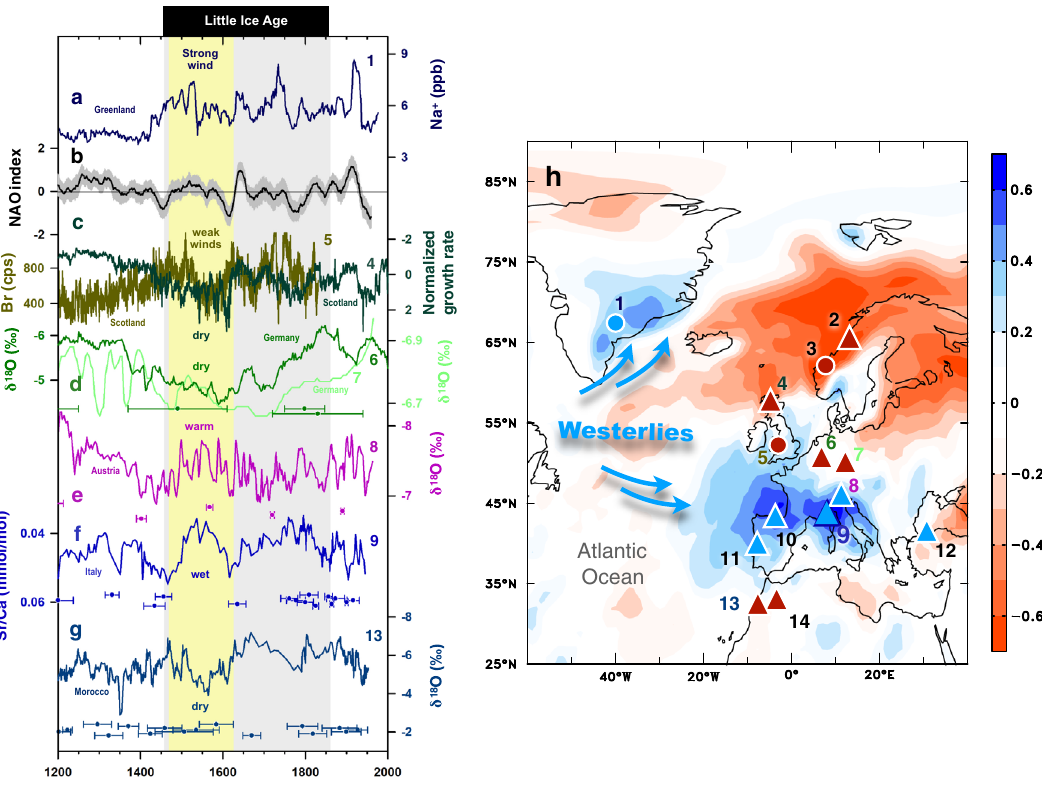
Fig.2|ClimaterecordsfromEuropeandnorthernAfricaforthelast800years. a Na + concentration in ice core GISP2 as an indicator of wind strength 34 . b Reconstructed North Atlantic Oscillation (NAO) index 11 . c Green: Stalagmite growth rate from Roaring cave (Scotland) as a proxy of precipitation amount. Low growth rate indicates positive NAO phase 35 . Mustard: Bromine concentration from aeoliansediments asaproxyof wind strength. High values indicate strong winds 36 . d Bunker (dark green) and Bleßberg (light green) δ 18 O record from Germany 37 – 39 . Lowvalues re fl ect a warm and wet climate. e Spannagel δ 18 O recordfromAustria 42 . Low values denote a warm climate. f Bàsura Sr/Ca record from northern Italy. g Ifoulki δ 18 O record from Morocco 46 . Grey vertical band marks the Little Ice Age. Theyellowverticalbarhighlightstheperiod1470-1610C.E.Colored-codeddotsand